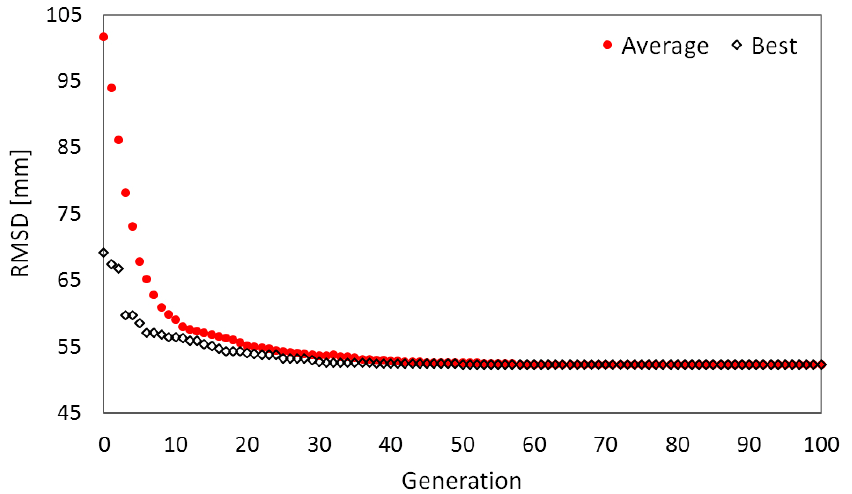
Figure 7. Variation of RMSD with each generation during genetic algorithm optimization for a bat made of white ash.